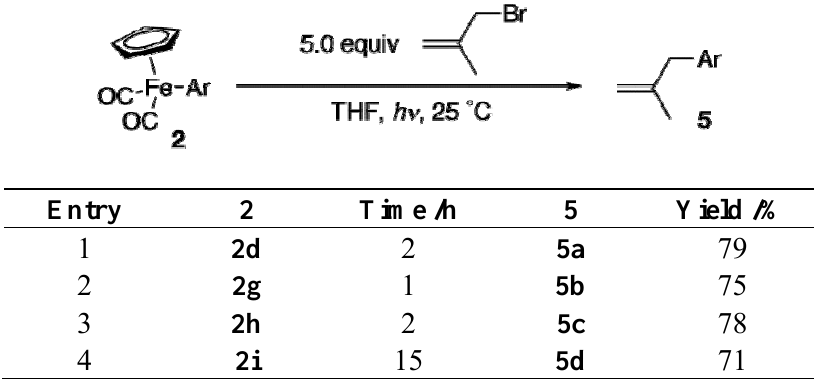
Table 6. Allylation of Functionalized Aryliron Complexes under UV